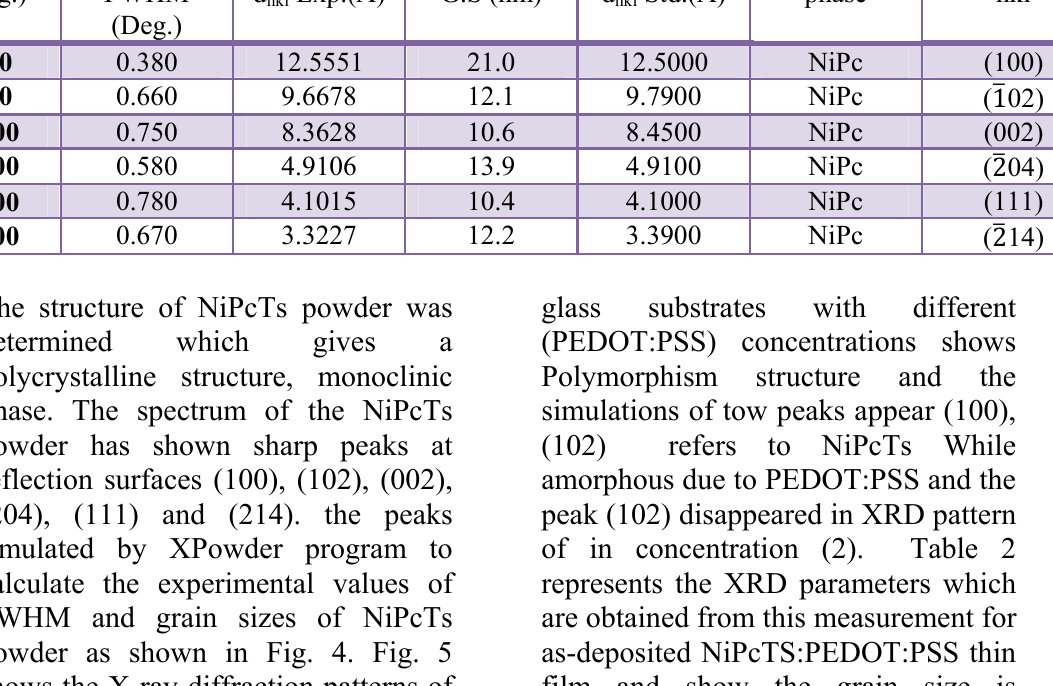
Table 1: Structural parameters viz. inter-planar spacing and crystalline size of pure NiPcTs 2 θ (Deg.)